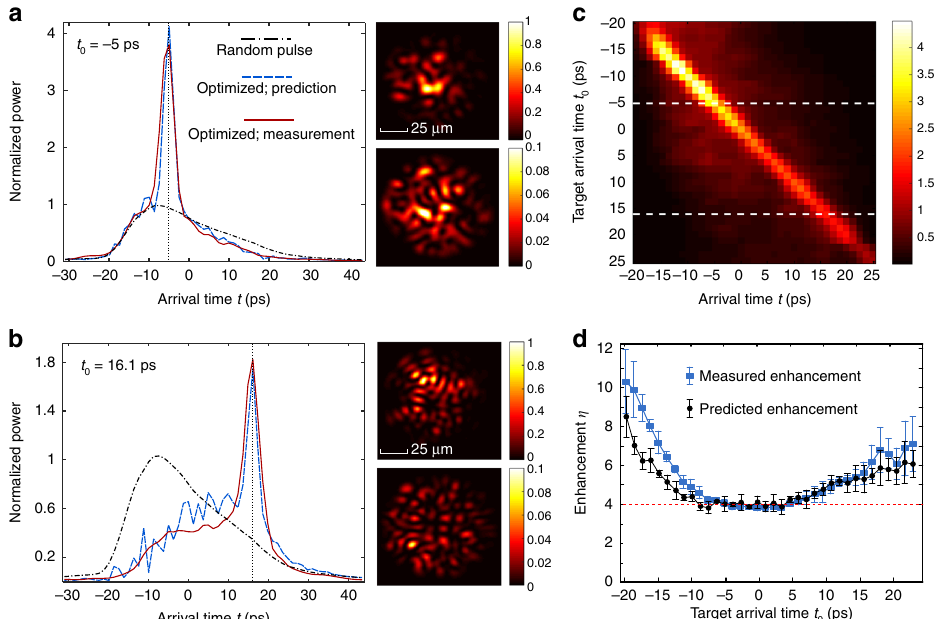
Fig. 3 Enhancing transmitted power at selected time. a , b Temporal shapes of the output pulse when the spatially integrated intensity (power) is optimized at arrival time ( a ) t 0 = − 5 ps and ( b ) t 0 = 16.1 ps. Red solid lines are the measured pulse shapes with optimized input wavefronts, the blue dotted lines are predicted from measured correlations C 2 ( t , t ′ ). They exhibit strong enhancement compared to the mean eigenvalues of u y ð t Þ u ð t Þ , which represents the mean output pulse shape for random input wavefronts (black dash-dotted lines). Transmitted powers are all normalized by the peak power of the transmitted pulse with random input wavefronts. The insets are spatial intensity patterns at t 0 for the optimized wavefront (upper panel) and a random wavefront (lower panel). The speckle grains at t 0 = − 5 ps are larger than those at t 0 = 16.1 ps, due to larger contributions from the lower-order modes at earlier arrival time. c Temporal shapes of pulses optimized at different t 0 , ranging from − 20 ps to 25 ps. The target time of a and b are marked by the white dashed lines. d Enhancement factor η of the transmitted power at the target arrival time t 0 . Blue squares: measured enhancement. Black circles: enhancement predicted from C 2 ( t ). Error bars represent the standard deviation among four measurements of the fi ber in different bending con fi gurations. Red dashed line indicates four times enhancement if C 2 ( t ) =